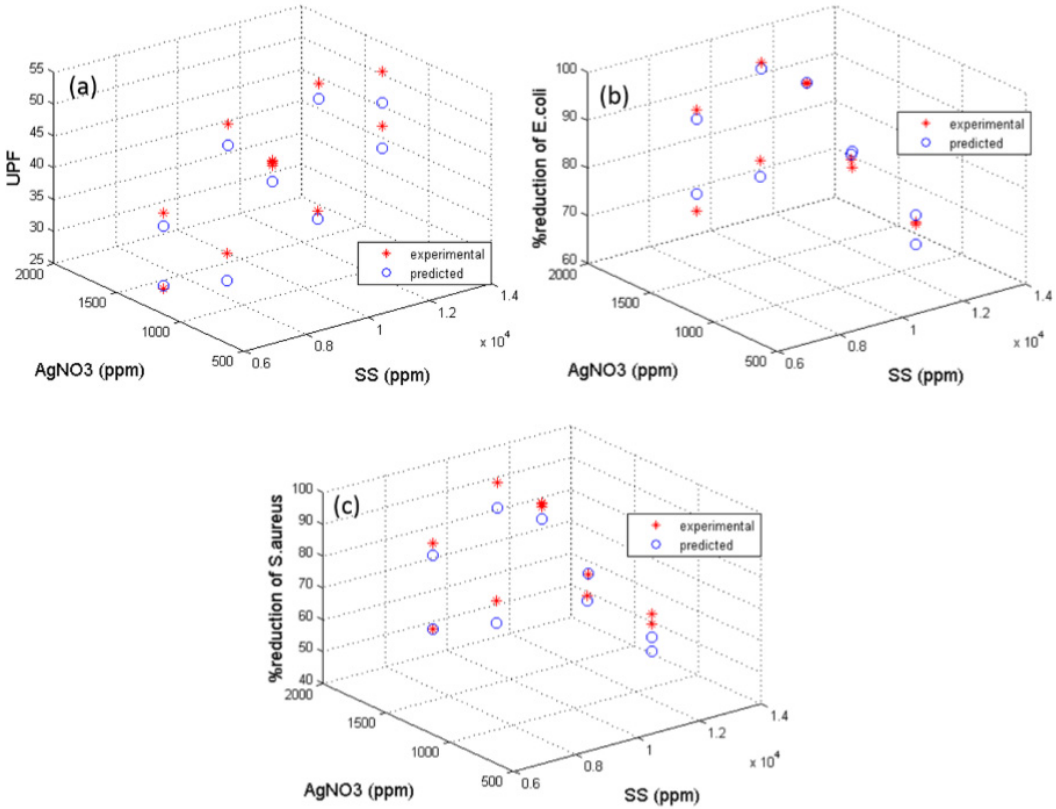
Figure 1. Predicted vs. experimental values at different levels of SS and AgNO 3 for ( a ) UPF ( Y 1); ( b ) %reduction of E. coli ( Y 2); and ( c ) %reduction of S. aureus ( Y 3).